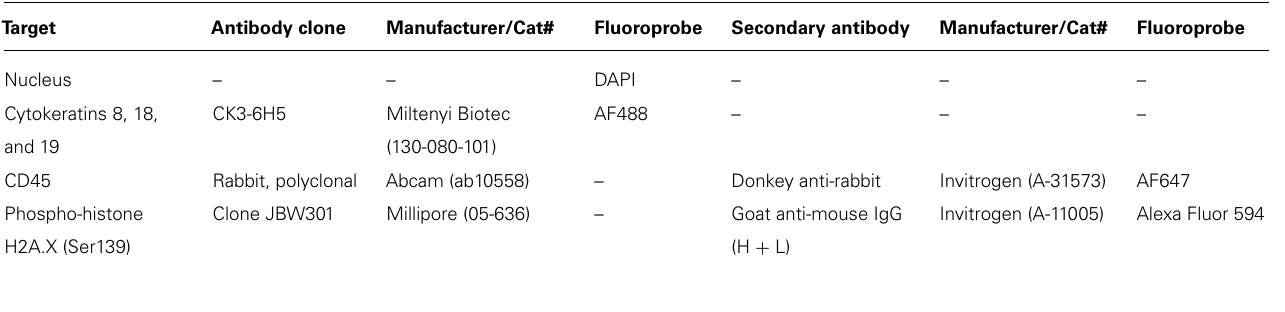
Table 1 |Antibodies and fluoroprobes used in this